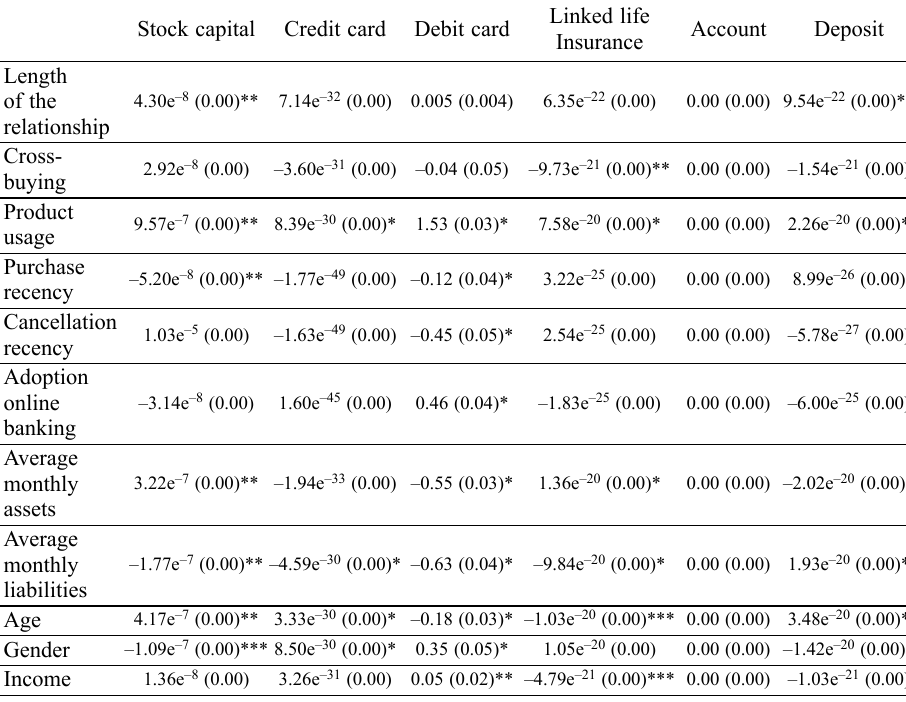
Table 5. Marginal effects for univariate Probit models (Coefficient (standard